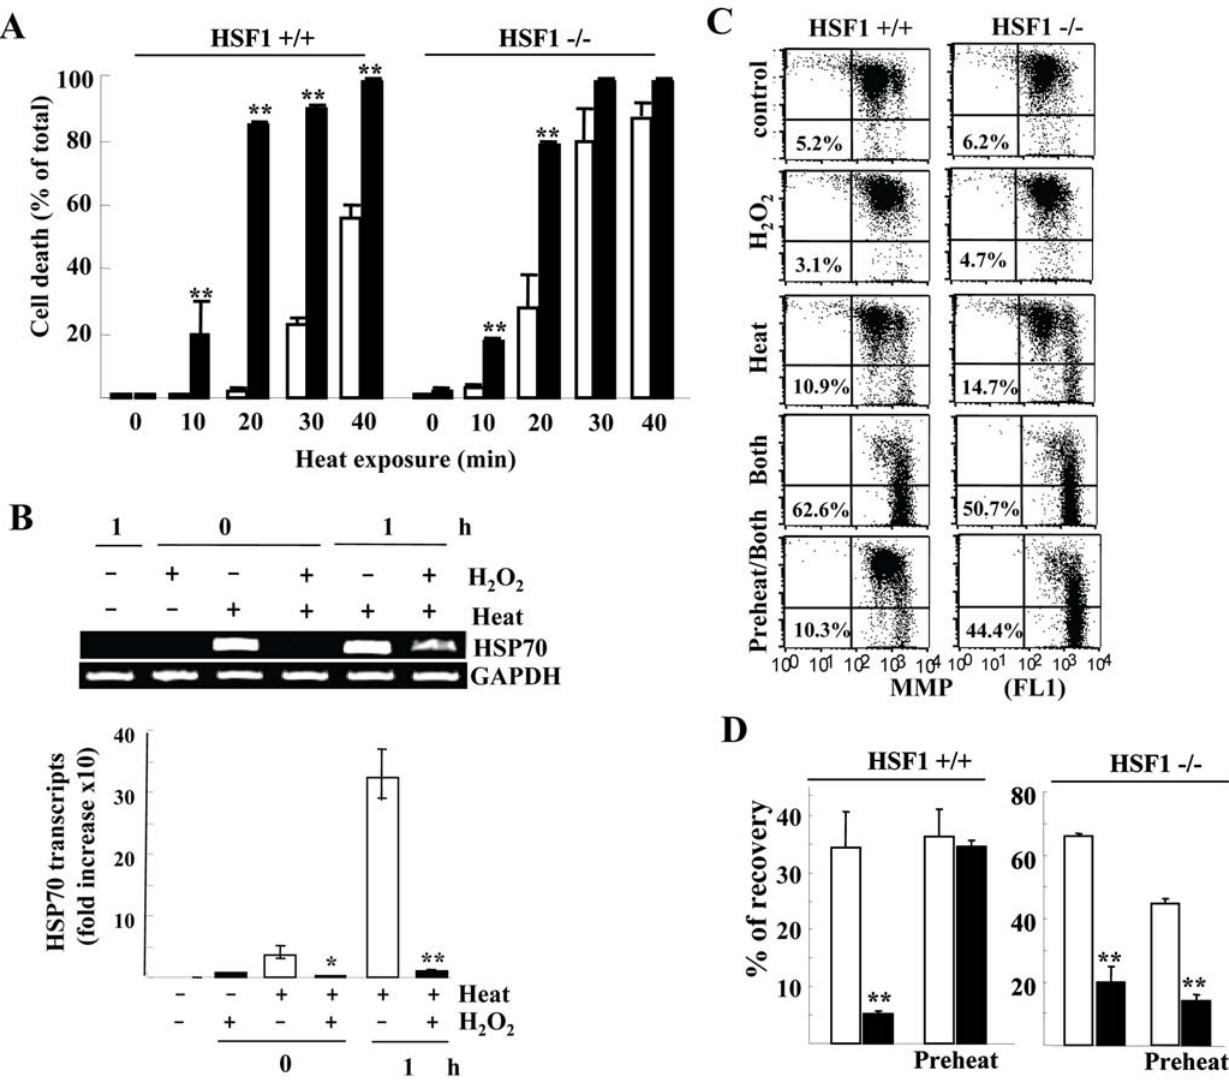
Figure 6. Effect of H 2 O 2 on heat-exposed HSF + / + and --/- MEFs. A ) Cell death at 24 h after heat exposure (42.5 u c for the indicated min) with (closed) or without (open bars) 0.5 mM H 2 O 2 pretreatment. B ) HSP70 transcripts evaluated by RT-PCR transcription at the indicated hours after the indicated treatments (upper) were determined by real-time PCR with normalization to GAPDH levels (lower panel). C ) Preconditioning effect on disruption of Dy m. Both MEF cells were treated as indicated, heat (Heat; 42.5 u c for 20 min), 0.5 mM H 2 O 2 treatment (H 2 O 2 ) and both treatments (Both). As thermal preconditioning, cells were preheated (40.5 u c for 30 min 10 h) prior to both treatments (Preheat/Both). Cells were cultured for 20 h after heat exposure and incubated with DePsipher solution. Numbers indicate % of cells showing loss of Dy m. D ) Effect of H 2 O 2 pretreatment on refolding activity. Refolding activity was evaluated by recovery of luciferase activity 5 h after heat exposure (42.5 u c for 20 min) with (closed) or without (open bars) 0.5 mM H 2 O 2 pretreatment. Cells were also treated by thermal preconditioning (Preheat) as described in C . In A , B and D , columns display the mean 6 S.D. of data from three separate experiments and *, P , 0.05; **, P , 0.01 compared with H 2 O 2 -untreated cells.